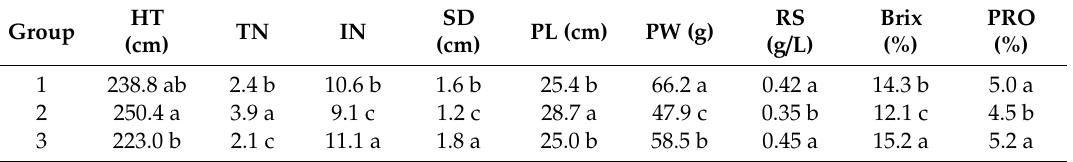
Table 3. Three population structure groups differing in plant height (HT), tiller number (TN), internode number (IN), stem diameter (SD), panicle length (PL), panicle weight (PW), reducing sugar (RS), Brix, and protein (PRO) in the population across three environments.